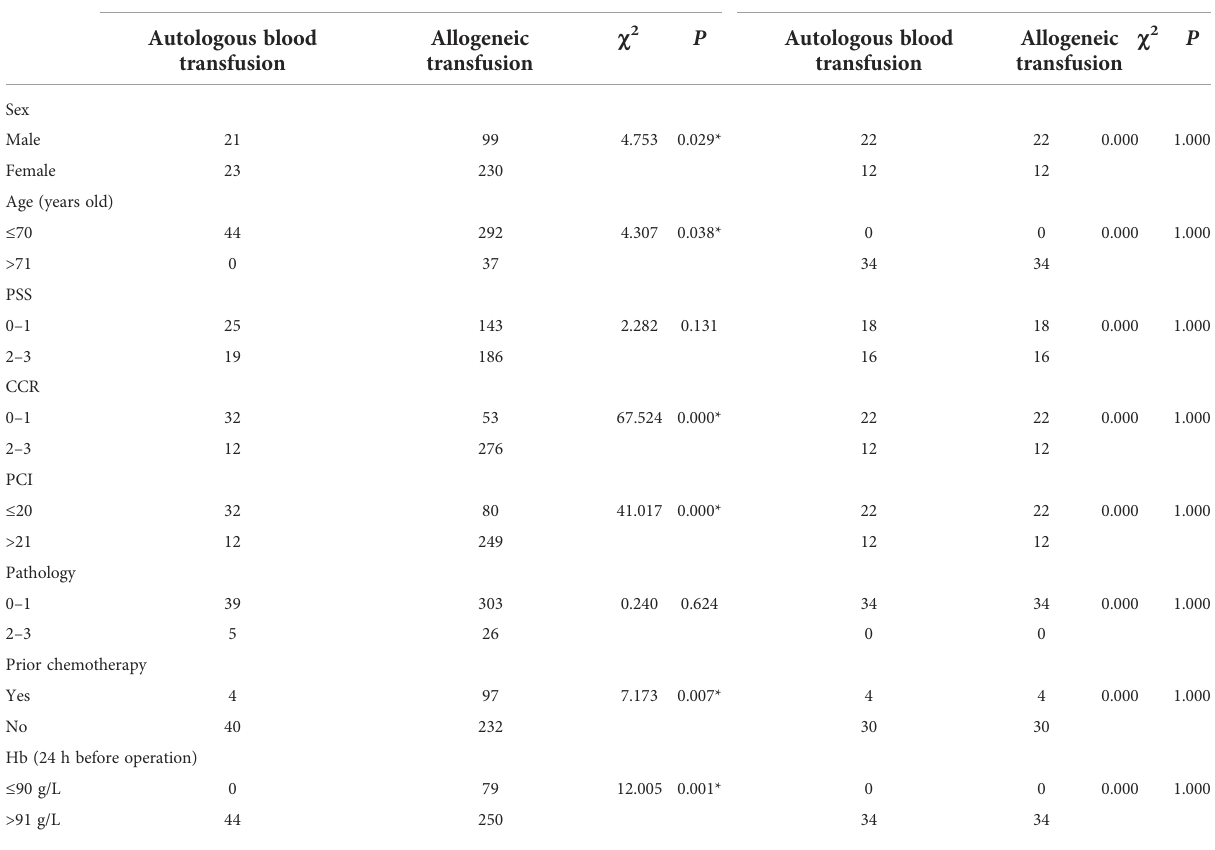
TABLE 1 Basic characteristics of the two groups of patients with PMP before and after PSM. Variable Before PSM After